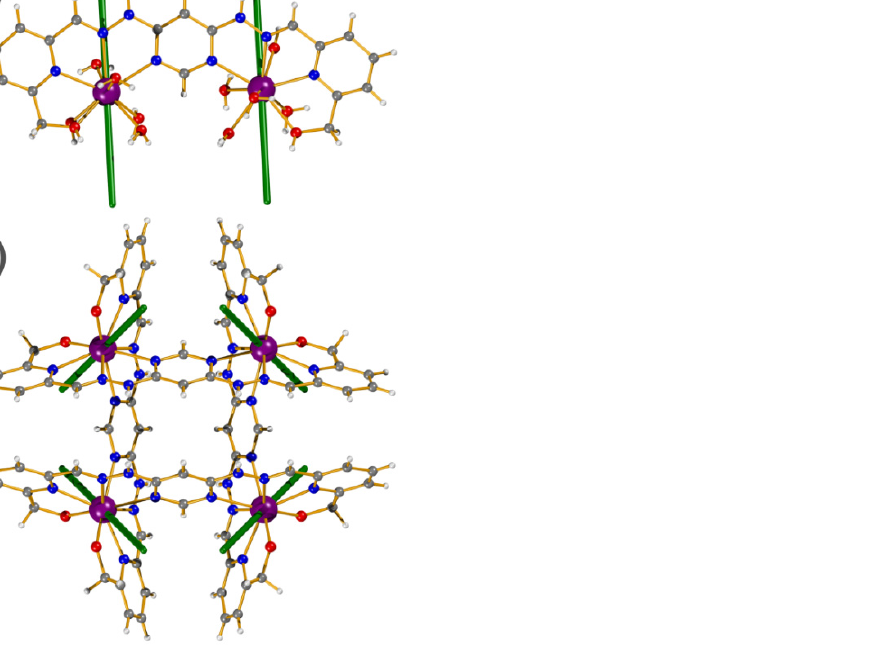
Figure 5. Orientations of the main magnetic axes of the ground state of Dy 2 ( a ) and Dy 4 ( b ) calculated based on the molecule structure.